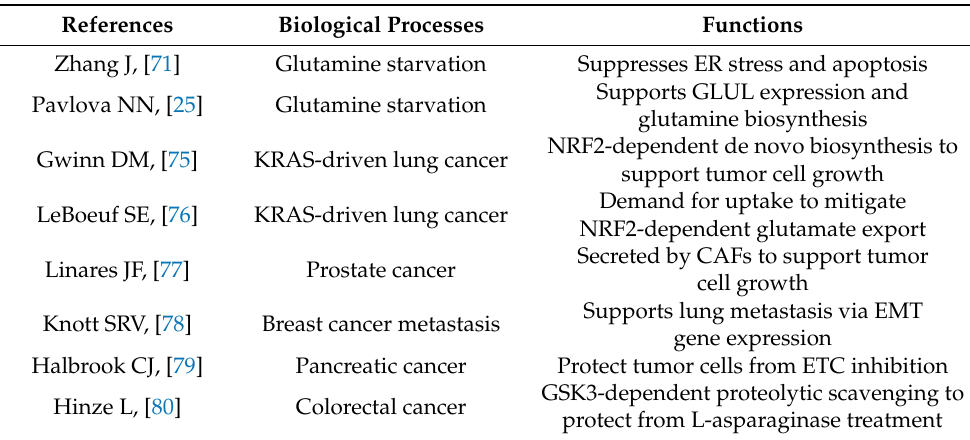
Table 1. Summary of the role of asparagine in solid tumor